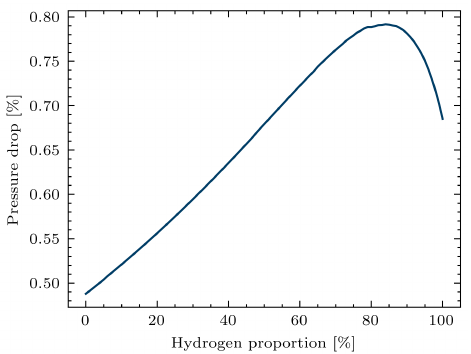
Figure 4. Pressure drop throughout a pipeline in relation to different hydrogen